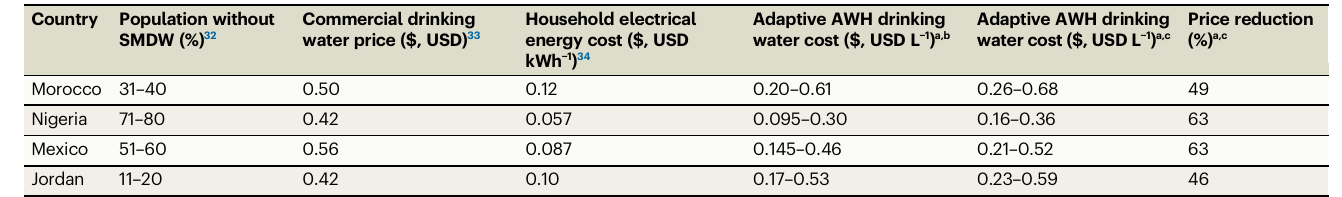
Table 2 | Price comparison of water produced by adaptive water harvesting (AWH) and commercial sources for representative lower-middle and upper-middle income countries Country Population without SMDW (%)